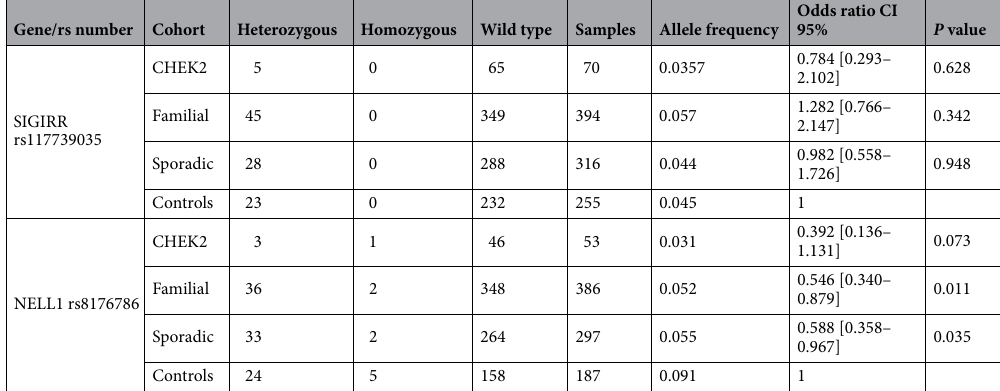
Table 5. Odds ratios for the 11 validated candidate alleles in CHEK2 :c.1100delC familial breast cancer and sporadic breast cancer. CI, confidence